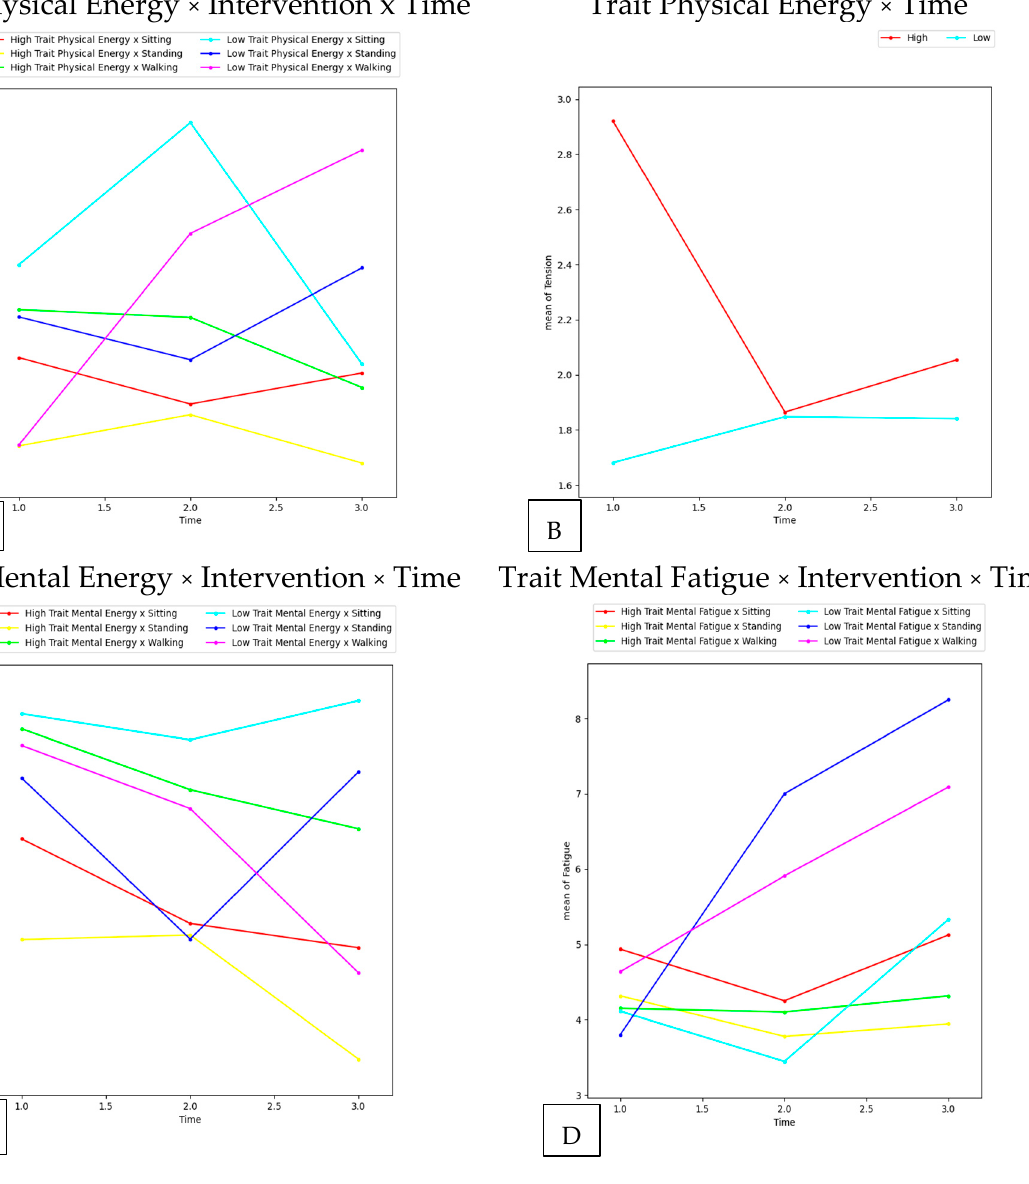
Figure 3. ( A ) Trait Physical Energy x Concentration Task Grid × Time interaction; ( B ) Trait Physical Energy × Time interaction for POMS Tension; ( C ) Trait Mental Energy × RVIP correct tertiary task × Time interaction; ( D ) Trait Mental Fatigue × POMS Fatigue × Time interaction.